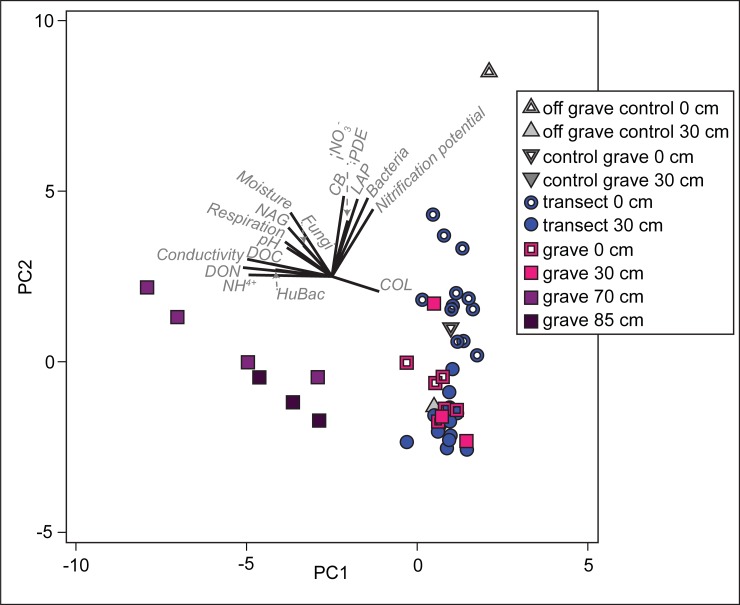
Principal components analysis of grave soils showing a clear difference in soil chemistry in samples from the bottom and below the grave.PC1 accounted for 33% of the variation; PC2 accounted for an additional 28.4%, for a cumulative variation explained of 61.4%.